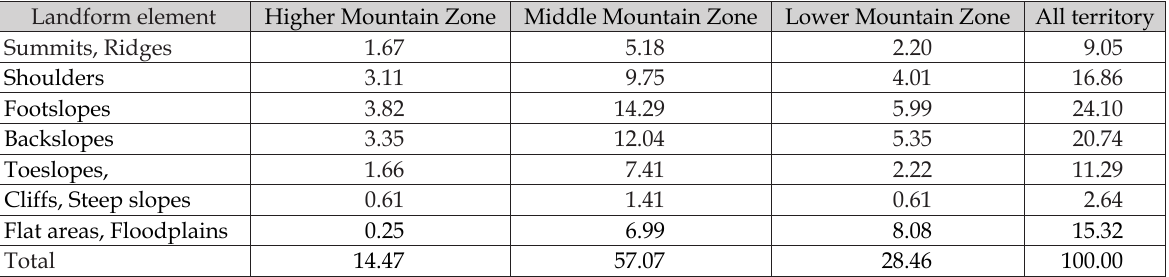
Table 4. The frequency of the spatial distribution of landforms in the territory of Armenia. Landform element Higher Mountain Zone Middle Mountain Zone lower Mountain Zone All